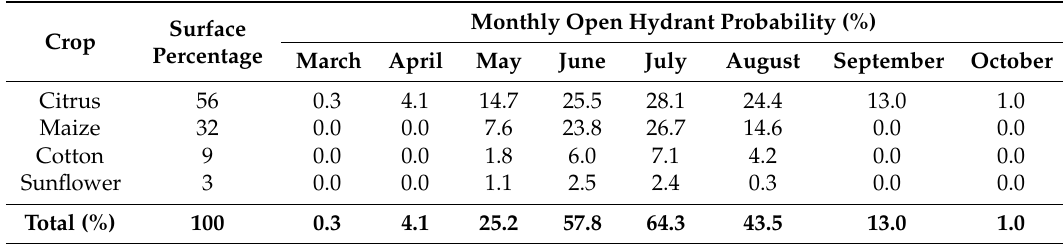
Table 1. Monthly open hydrant probability by crops depending on the surface occupied, and total monthly open hydrant finally applied to every hydrant during the irrigation season.